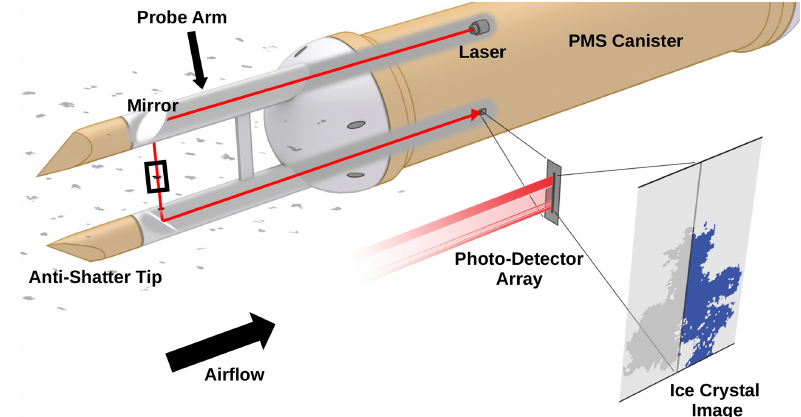
Figure 1. Illustration showing the side view of a two-dimensional optical array probe in a Particle Measurement Systems, Inc., (PMS) canister. Images are obtained as particles pass through the laser beam (solid, red line) when the aircraft’s speed creates airflow past the probe. The laser beam is directed between the probe arms using two 90 ◦ mirrors. Particles passing through the laser beam block light, causing reduced illumination on some diodes in the photodiode array. Images are produced when at least one array element is reduced in intensity by a set amount (e.g., > 50%). The depth of field (the location where the particle must cross the beam to be clearly imaged) is indicated with a black rectangle. The sampling frequency of the photodetector array is adjusted using the measured true airspeed, so images (example given in lower right) have symmetric pixel elements. Heated, anti-shattering tips prevent ice accretion and reduce the number of shattered particles that enter the sample volume (Korolev and Isaac, 2005). Credit: Nowatzki, 2019.